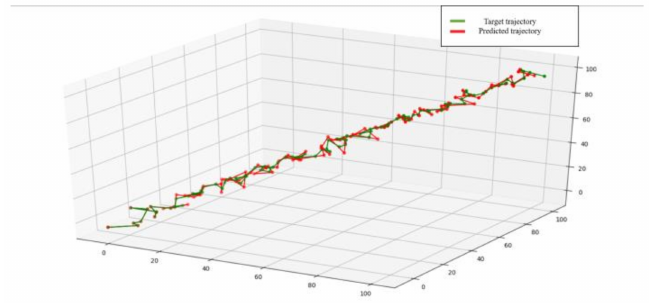
Figure 18. Kalman filtering estimation of the moving target movement along an inclined stair.